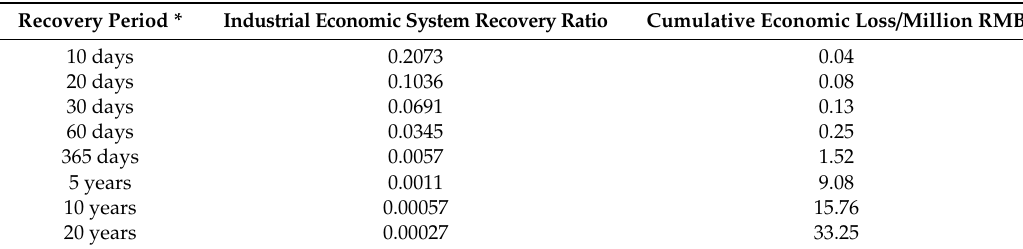
Table 4. Cumulative economic loss value in di ff erent recovery